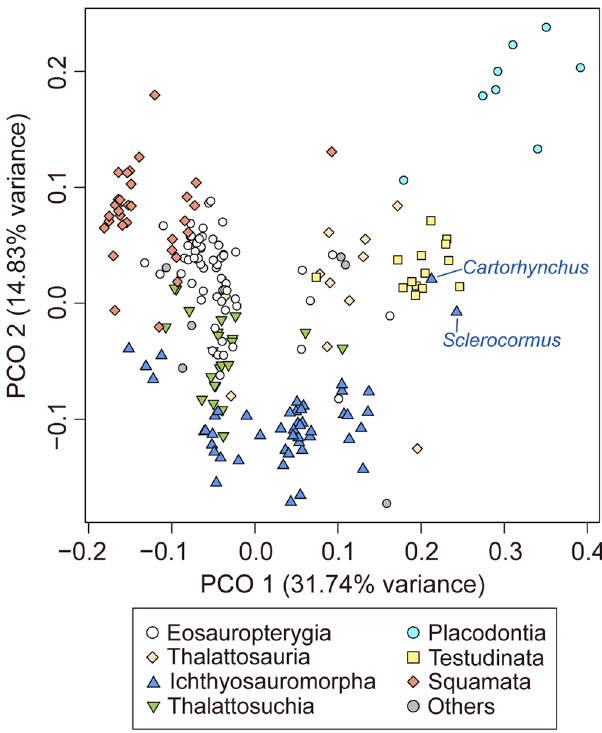
Fig. 10 Functional morphospace showing the distribution of Mesozoic marine